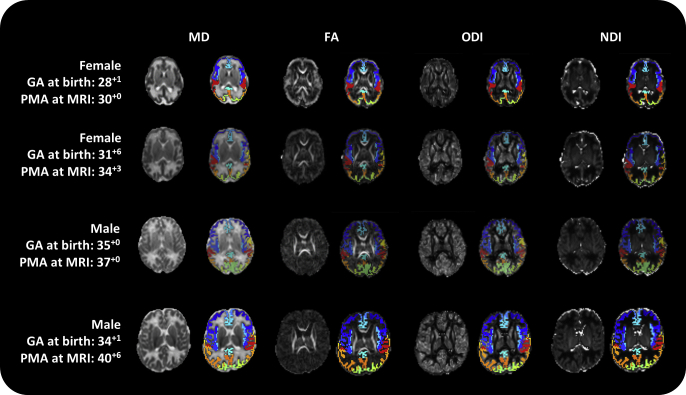
Regional grey matter parcellation overlayed on MD, FA, ODI and NDI in 4 representative subjects.